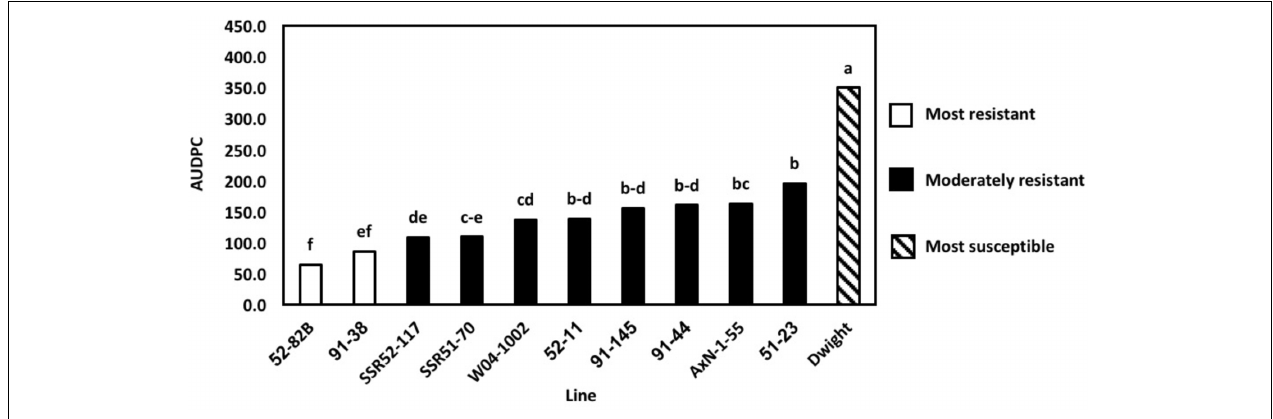
FIGURE 3 | Area under the disease progress curve (AUDPC) of multi-isolate greenhouse evaluations. Means followed by the same letter are not significantly different based on Fisher’s Least Significant Difference (LSD; α = 0.05). LSD values were calculated based on the lognormal transformed AUDPC